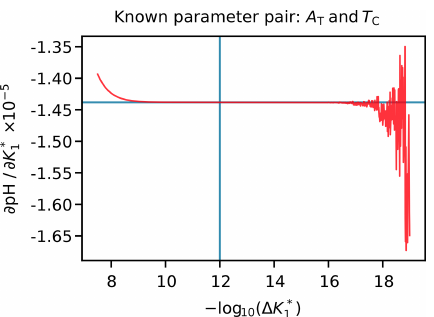
Figure 3. An example figure used to select a suitable (cid:49)a value for uncertainty propagation, in this case for (cid:49)K ∗ . The pH was calcu- 1 lated from A T and T C , and then the value of K ∗ was incremented 1 by the amounts shown on the horizontal axis; the vertical axis is for the corresponding gradient calculated from the pH response, shown by the red curve. The perpendicular blue lines show the (cid:49)a value selected in this case (i.e. 10 − 12 ), which falls within the flat section towards the centre of the figure. To the left of this (i.e. at higher (cid:49)a ), the upwards curvature of the red line is due to non-linearity, while the erratic deviations to the right (i.e. at lower (cid:49)a ) are due to solver tolerance and computer precision